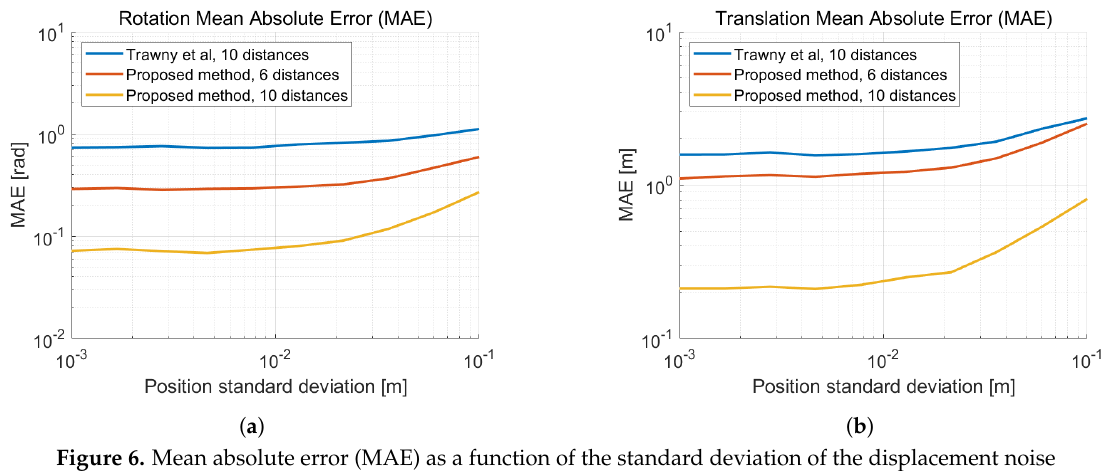
Figure 6. Mean absolute error (MAE) as a function of the standard deviation of the displacement noise σ p and a distance standard deviation σ d = 2cm. ( a ) MAE of the rotation with respect to the ground truth. ( b ) MAE of the translation with respect to the ground truth.